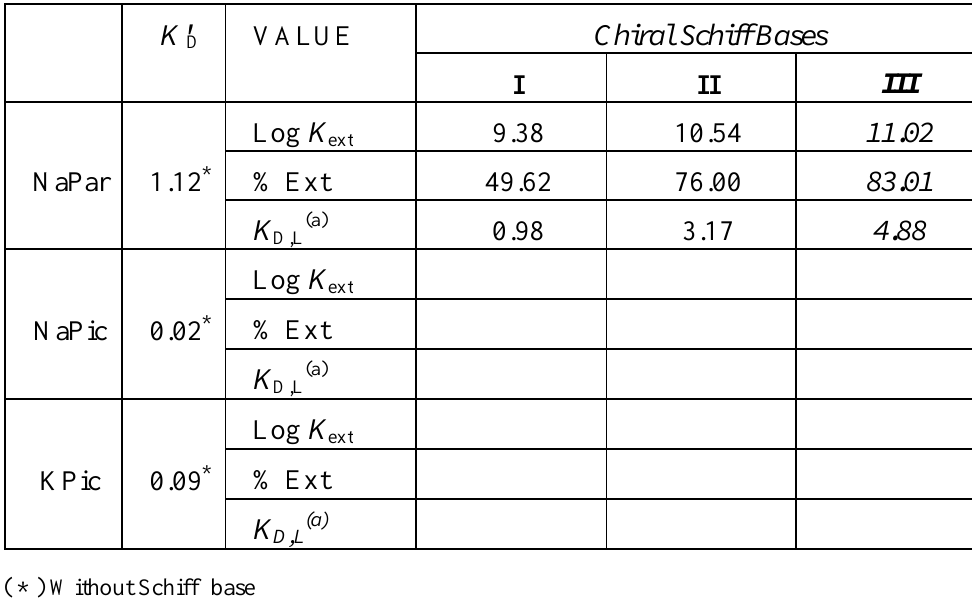
Table 1. Equilibrium constants for extractions of NaPar, NaPic and KPic with chiral Schiff bases in CH Cl at 25 o C. 2 2